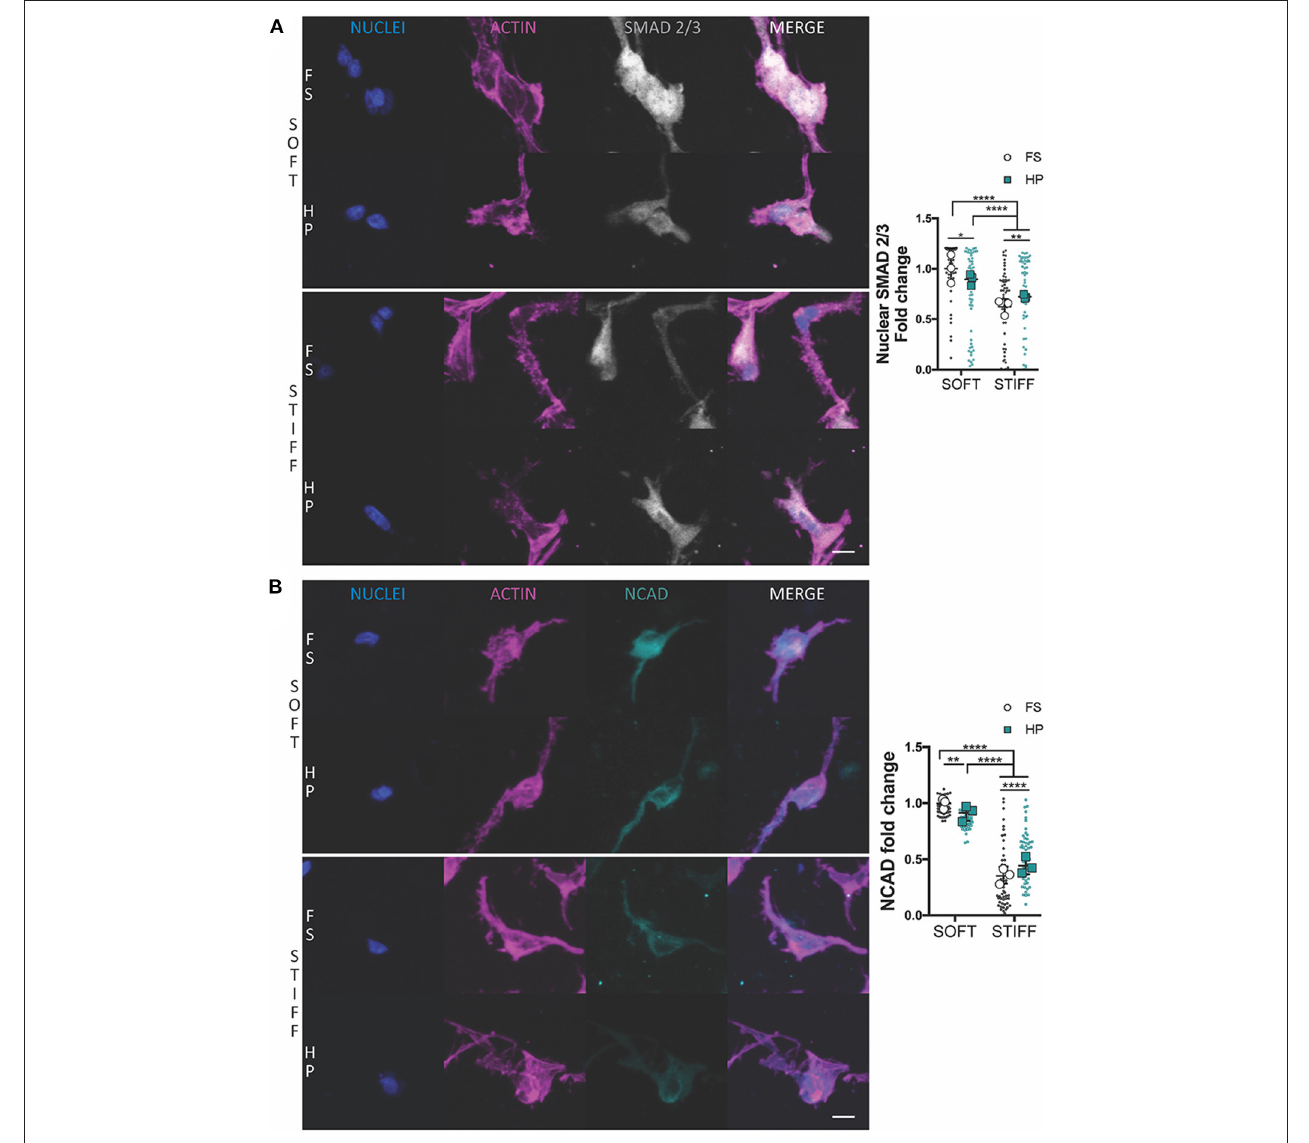
FIGURE 2 | The influence of HP on nuclear SMAD 2/3 and NCAD levels in MSCs cultured within soft and stiff IPN hydrogels. Confocal analysis of MSCs cultured for 7 days in presence of TGF- β 3 + HP. Cells stained for nuclei (blue), actin (magenta) and (A) SMAD 2/3 (gray) or (B) NCAD (cyan). Scale bars, 10 µ m. Quantitative analysis of confocal images to determine the fold change of (A) the nuclear content of SMAD 2/3 and (B) NCAD expression. * p < 0.05, ** p < 0.01, **** p <